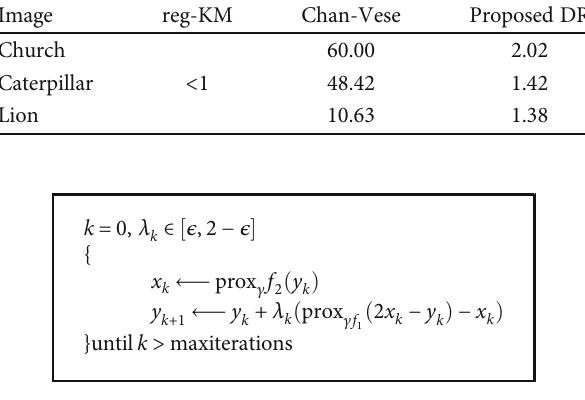
Table 3: Comparison of reg-KM, Chan-Vese algorithm, and proposed DR algorithm in terms of execution time